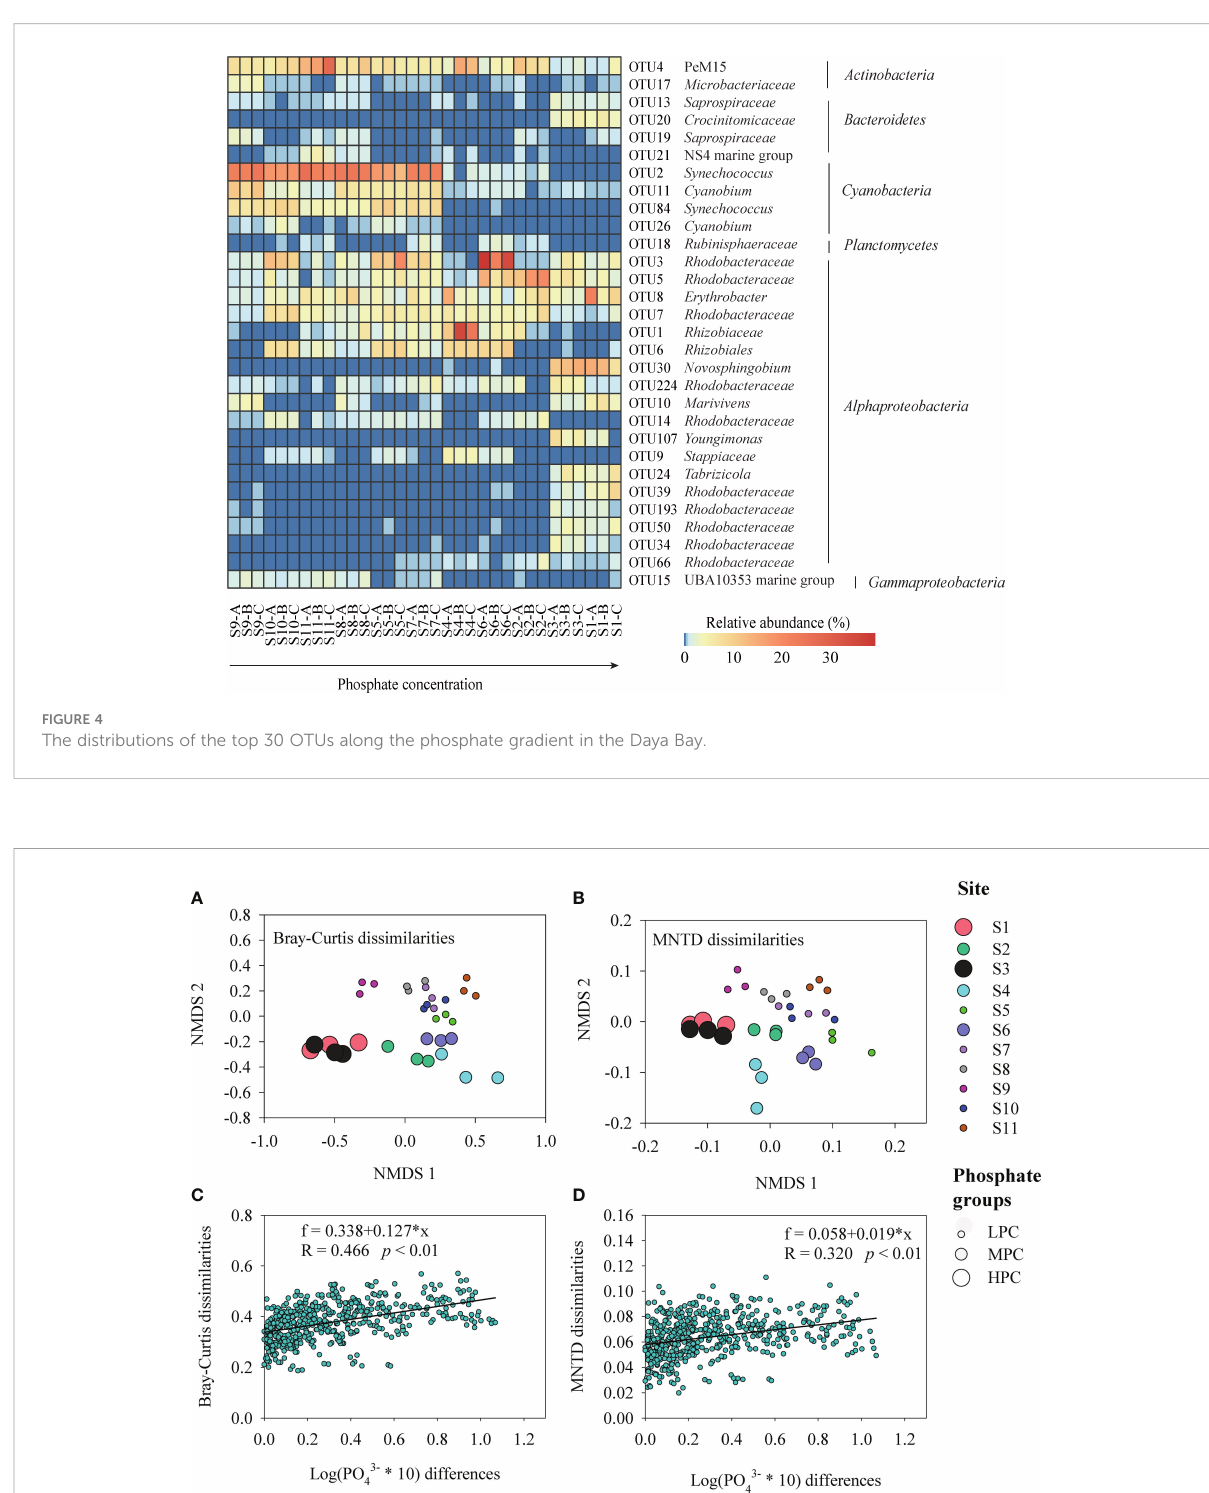
FIGURE 5 Non-metric multidimensional scaling (NMDS) ordinations showing the distributions of bacterial community compositions (BCCs) in the Daya Bay according to the phosphate gradient both based on BCC Bray-Curtis dissimilarity (A) and inter-community mean nearest taxon (MNTD) dissimilarity (B) . Relationships between BCC Bray-Curtis (C) and MNTD (D) dissimilarities with the differences of phosphate concentration. The formulas, R values, and signi fi cances are given in each panel. LPC: the low phosphate concentration (phosphate< 0.5 mg L -1 ), MPC: the medium phosphate concentration (0.5 mg L -1 < phosphate< 1.0 mg L -1 ), and HPC: the high phosphate concentration (phosphate > 1.0 mg L -1